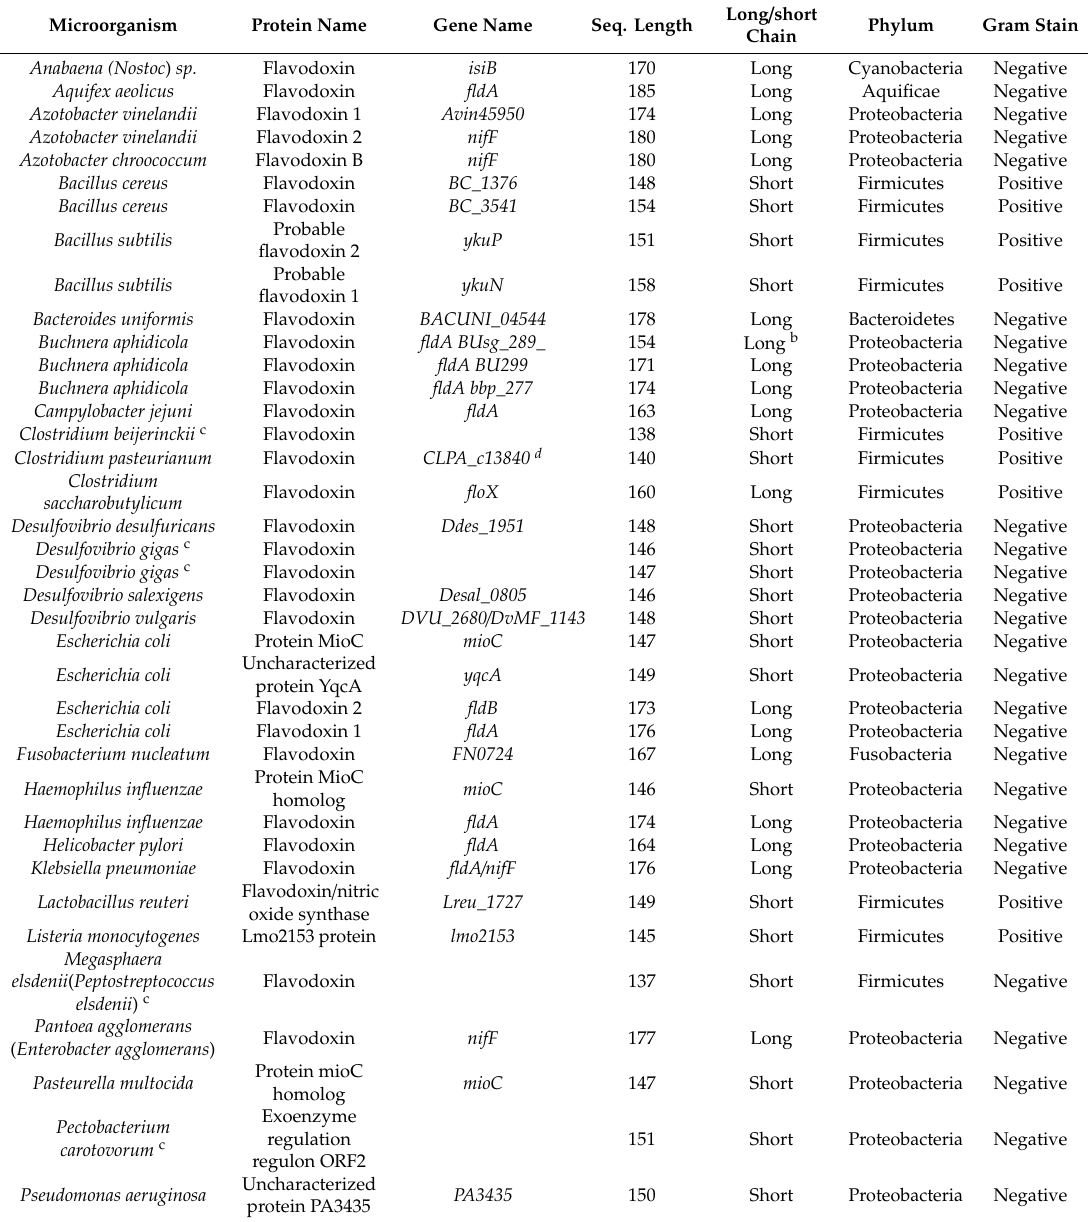
Table 2. Some flavodoxin-containing bacteria a